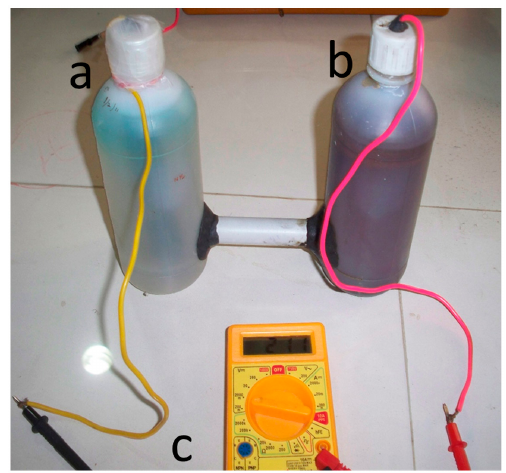
Fig. 1. Microbial fuel cell – double chambered fuel cell (with nafion membrane) a) anode chamber, b) cathode chamber c) multimeter.